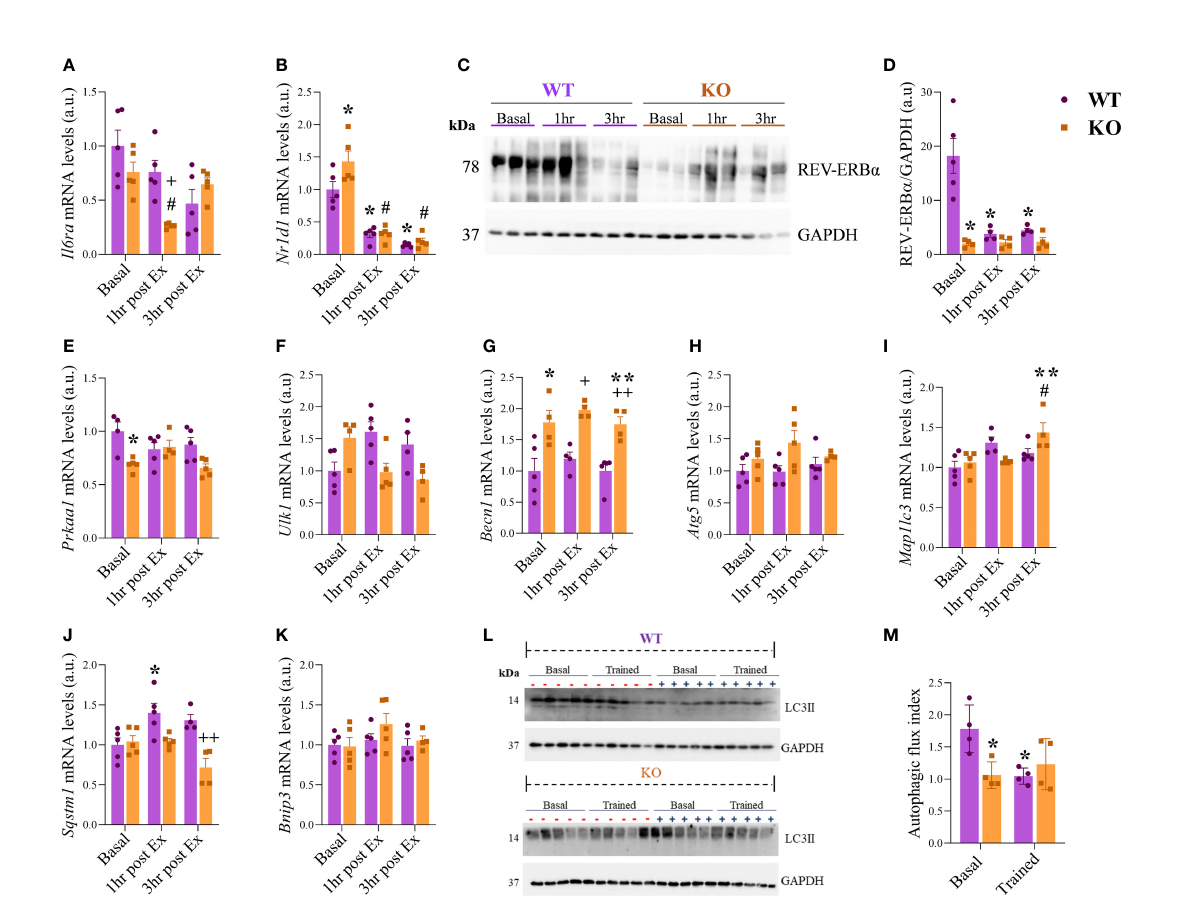
FIGURE 3 mRNA and protein levels of Nr1d1 and autophagic pathway. Il6ra (A) ; Nr1d1 (B) ; Representative blots (C) ; REV-ERB a /GAPDH (D) ; Prkaa1 (E) ; Ulk1 (F) ; Becn1 (G) ; Atg5 (H) ; Mapllc3 (I) ; Sqstm1 (J) ; Bnip3 (K) ; Representative membranes of the autophagic fl ux (L) ; Autophagic fl ux index (M) . Data correspond to the mean ± SEM of n=4-5 mice/group for RT-qPCR and n=5-6 mice/group for western blotting. *p ≤ 0.05 vs. WT at Basal; #p ≤ 0.05 vs. IL-6 KO at Basal; +p ≤ vs. WT at 1hr post-Ex; **p ≤ 0.05 vs. KO at 1hr post-Ex; ++p ≤ vs. WT at 3hr post-Ex. Basal (sedentary; Basal), 1 hour (after 1h of the acute exercise; 1hr post-Ex), and 3 hours (after 3h of the acute exercise; 3hr post-Ex). a.u., arbitrary